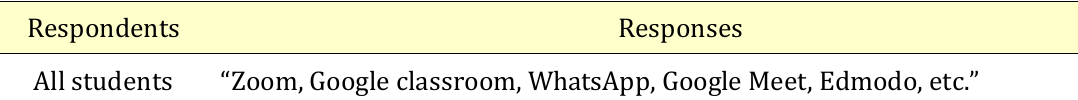
Table 4. Students from the 5th semester of English Education’s response Respondents